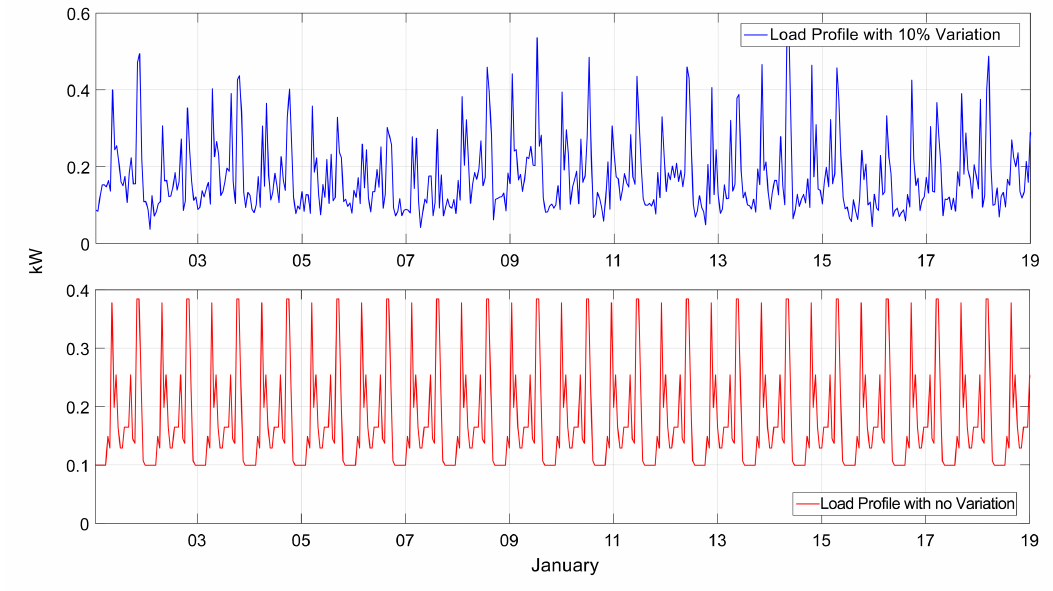
Figure 10. January load profile showing 10% variability in consumption.